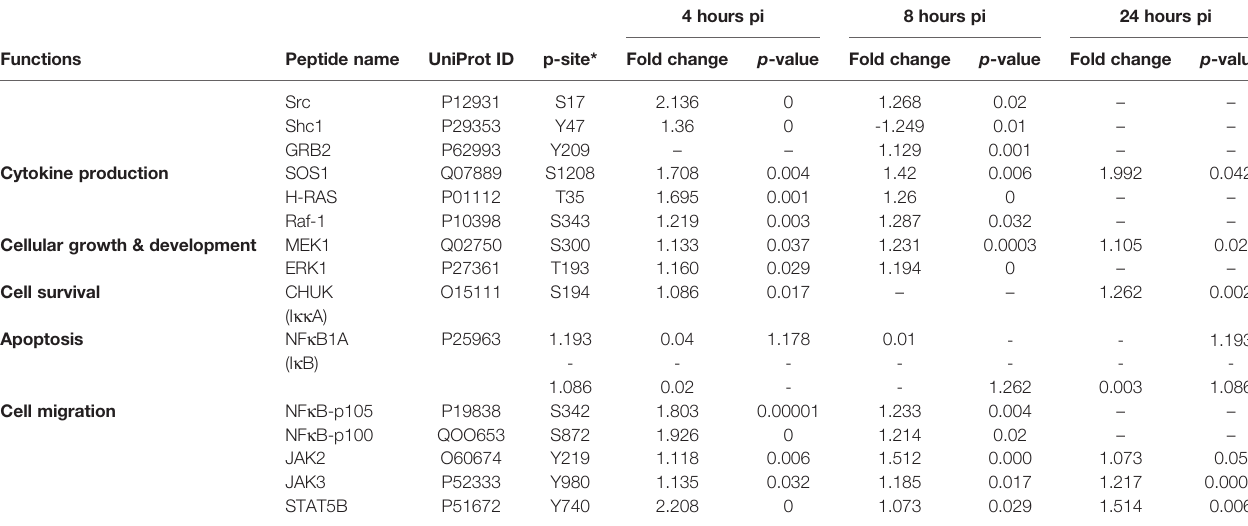
TABLE 6A | Members of the chemokine signaling pathway showing differential phosphorylation between Salmonella enterica serovar Enteritidis-infected cecal tissue and non-infected cecal tissue: MAPK and JAK-STAT signaling pathways.